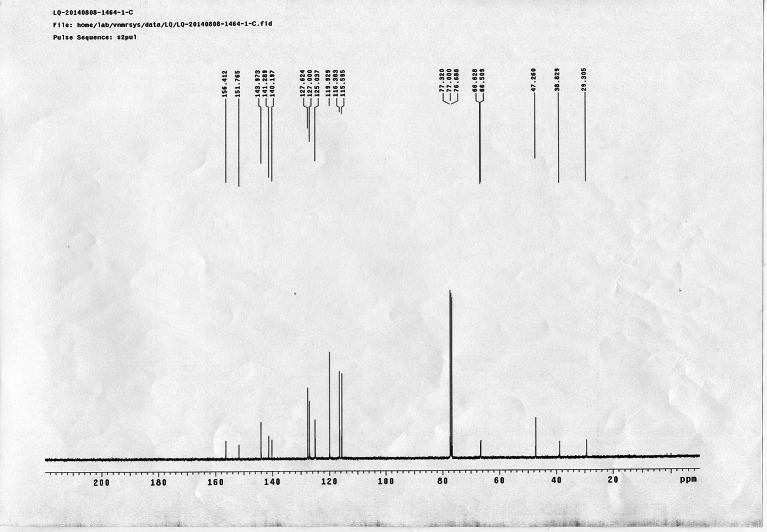
13C NMR spectra of compound 21.